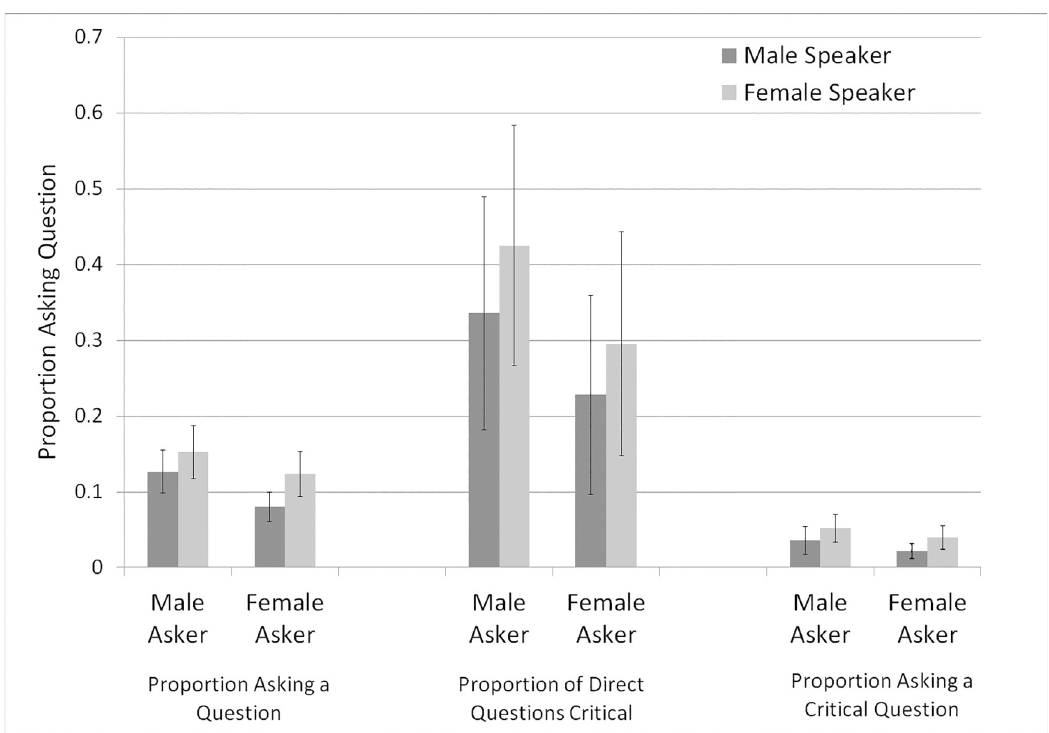
Fig 1. Estimated probabilities of questions being asked by gender of speaker and asker. (Below Fig 1): Estimates are calculated probabilities based on analyses of P2b, P3a, and P4b with controls set to sample means. Error bars are standard errors.